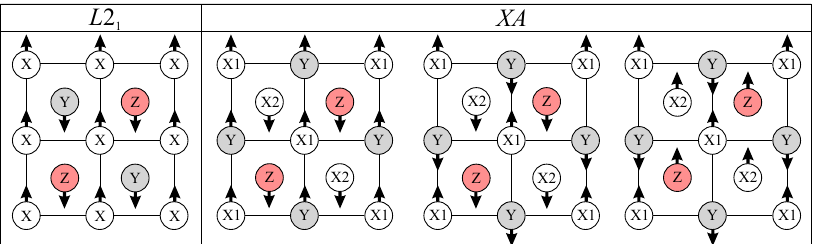
Figure 7. The types of initial antiferromagnetic configurations for L 2 1 and XA